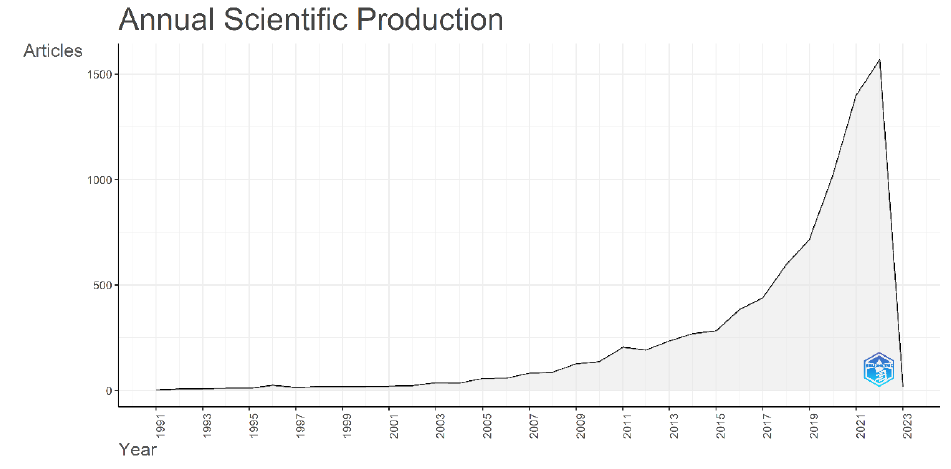
Figure 2. Evolution of production over time .